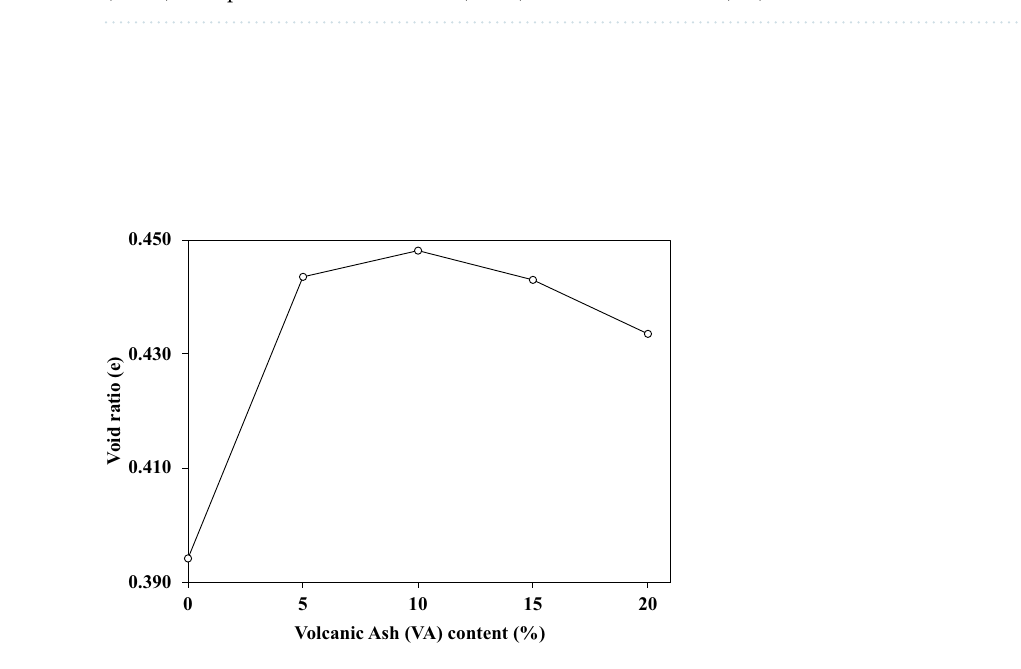
Figure 6. Variation of the void ratio with the volcanic ash (VA)